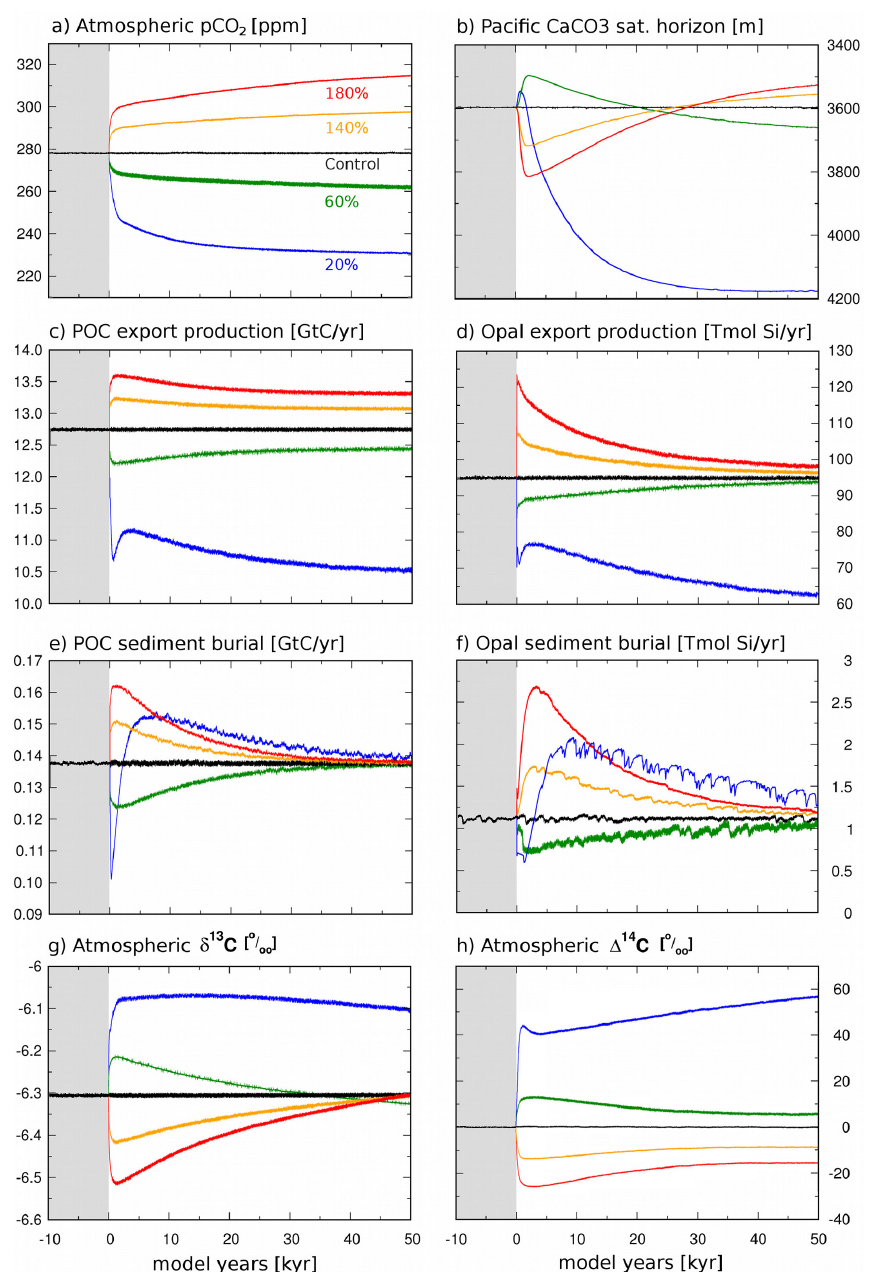
Fig. 6. Ocean ventilation experiments: time-dependent carbon cycle response of the coupled ocean-sediment system to changes in deep ocean ventilation induced by scaling the amplitude of windstress and deep convection in the Southern